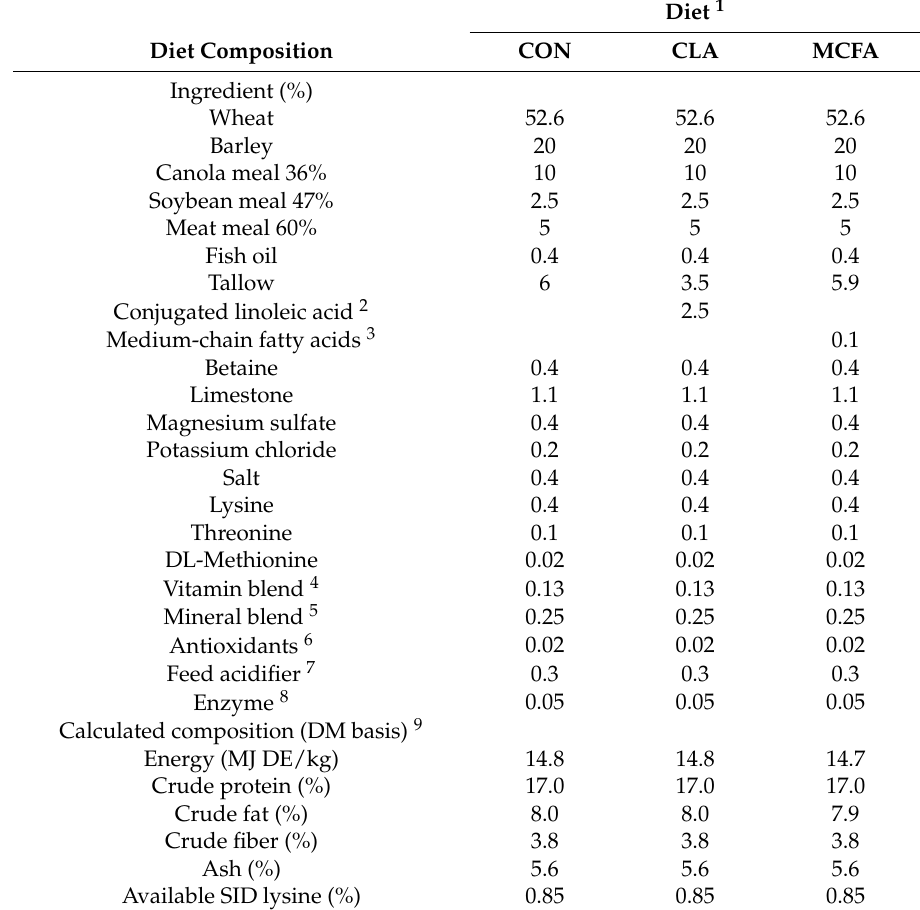
Table 1. Composition of experimental diets fed in late gestation and